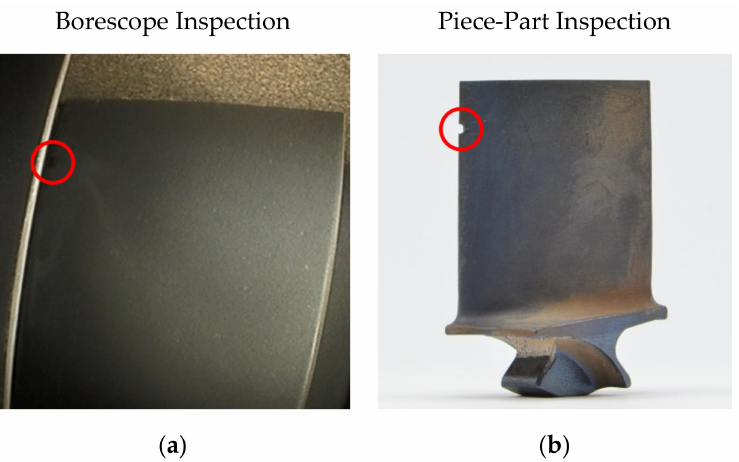
Figure 4. Blade with nick on leading edge at different inspection levels: ( a ) borescope inspection; ( b ) piece-part